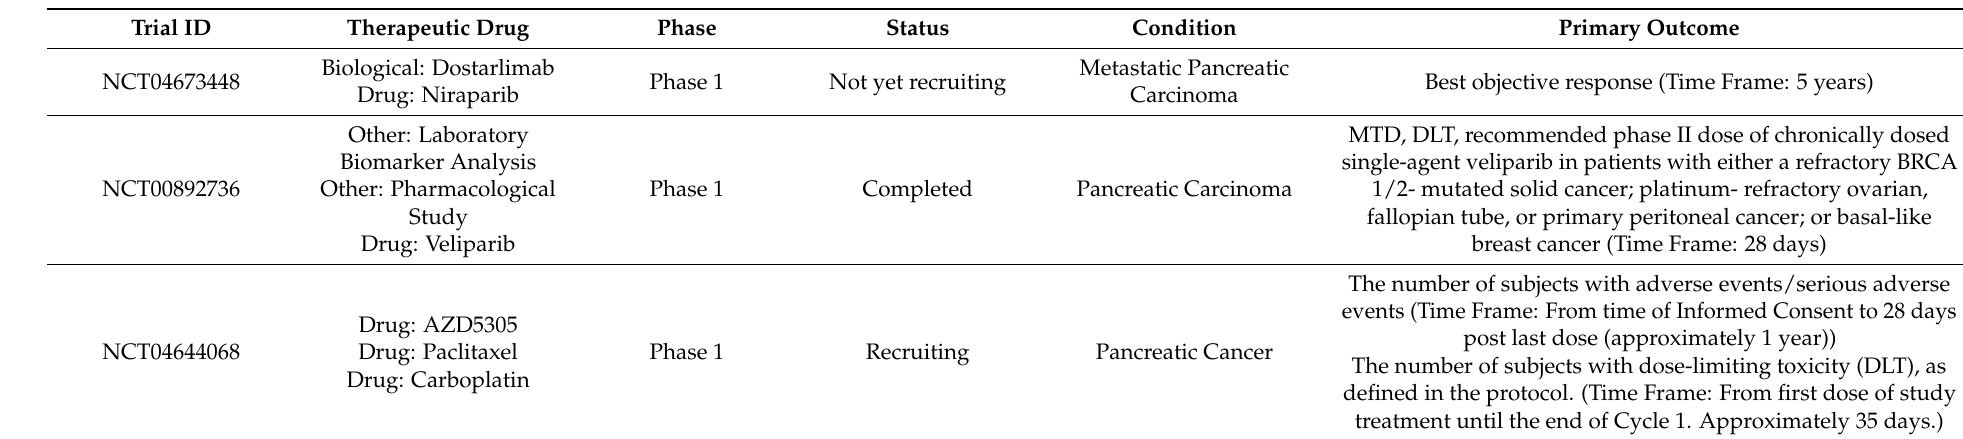
Table 2. Recent clinical trials of PARP inhibitors in human pancreatic